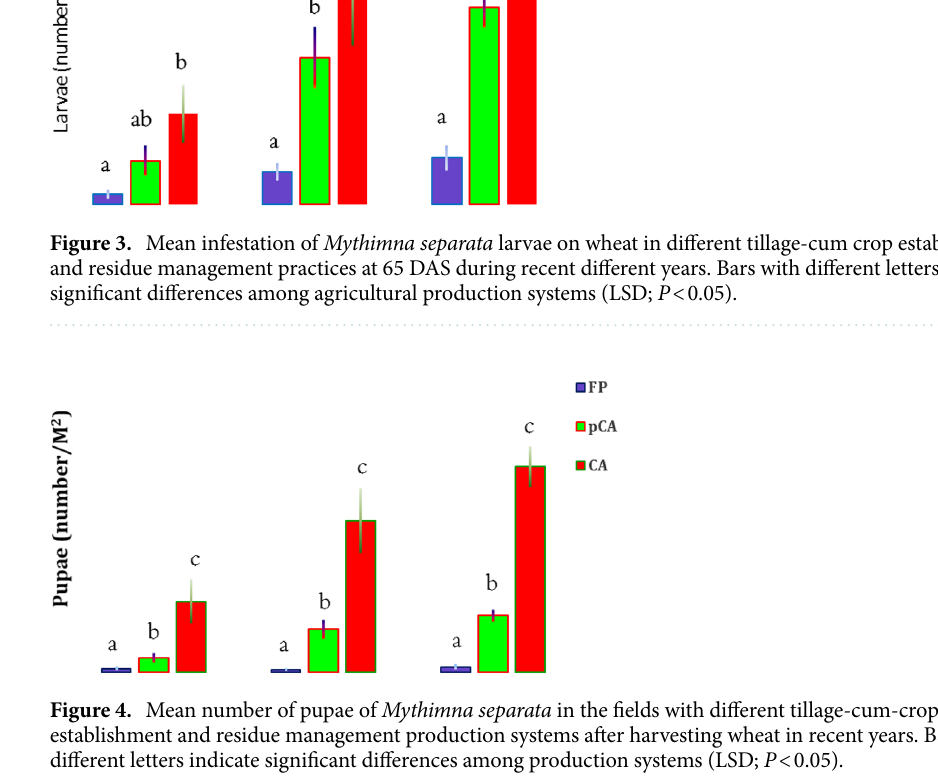
Number of larvae (m −2 ) Number of pupae (m −2 Scenarios*